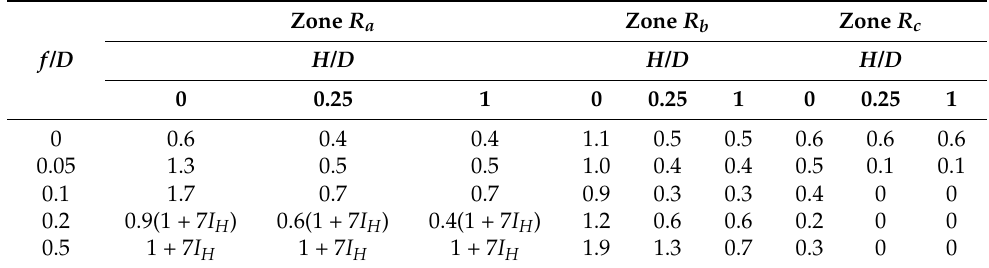
Table 5. Positive peak pressure coefficients for cladding design prescribed in AIJ-RLB (2015) [22].